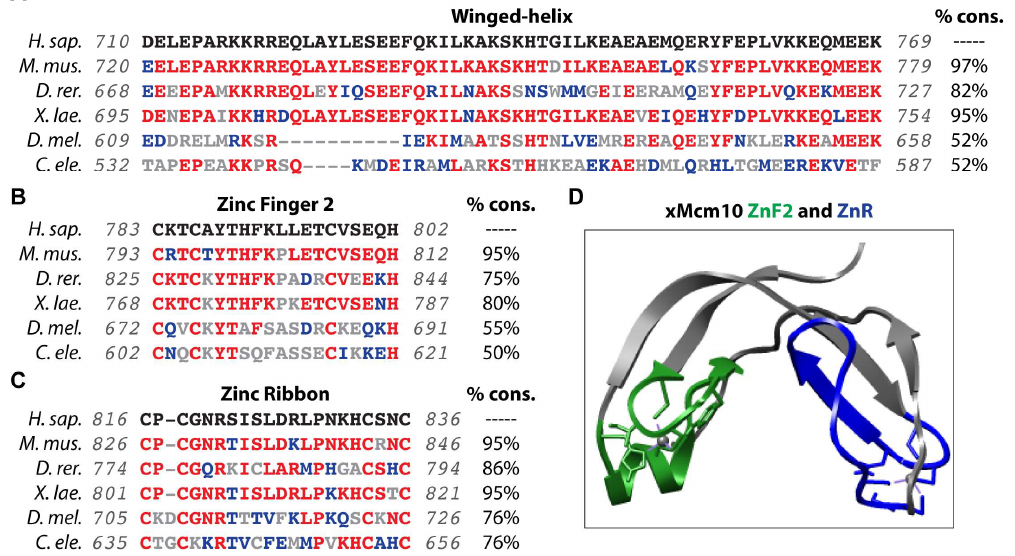
Figure 4. Evolutionary conservation of functional domains in the Mcm10 CTD. ( A – C ) Comparison of the amino acid sequences from H. sapiens , M. musculus , D. rerio , X. laevis , D. melanogaster and C. elegans of the Winged Helix ( A ), Zinc-Finger 2 ( B ) and Zinc-Ribbon ( C ). The percent conservation (% cons.), defined as the percentage of amino acid positions identical (in red) or strongly similar (in blue) to those of human Mcm10, is listed for each domain sequence. The total region aligned for each sequence listed in gray. ( D ) The crystal structure of the Xenopus Mcm10 (xMcm10) Zinc-Finger 2 (green) and Zinc-Ribbon (blue) domains is shown. The structure was generated using pdb data file 2KWQ and the Chimera program (http://www.cgl.ucsf.edu/chimera) [83].